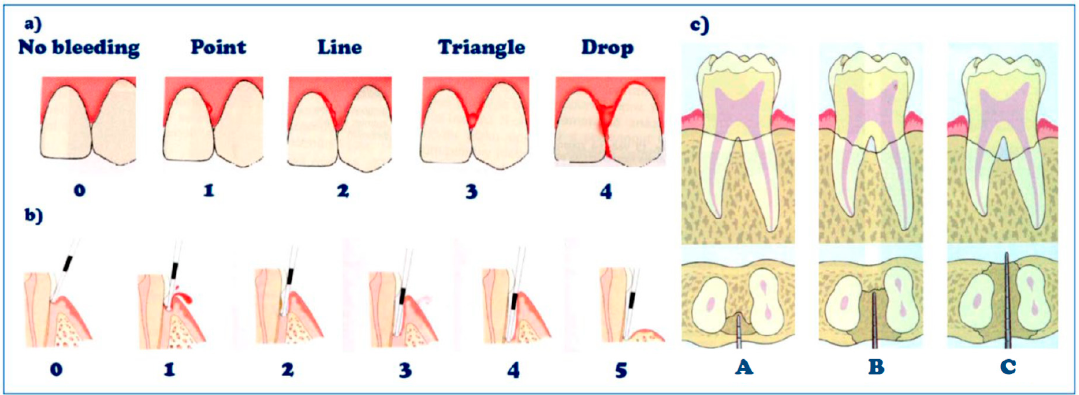
Figure 16. Characteristic damage caused by the development of the periodontal disease: ( a ) papilla bleeding; ( b ) depth of periodontal pockets; ( c ) classes of furcations.